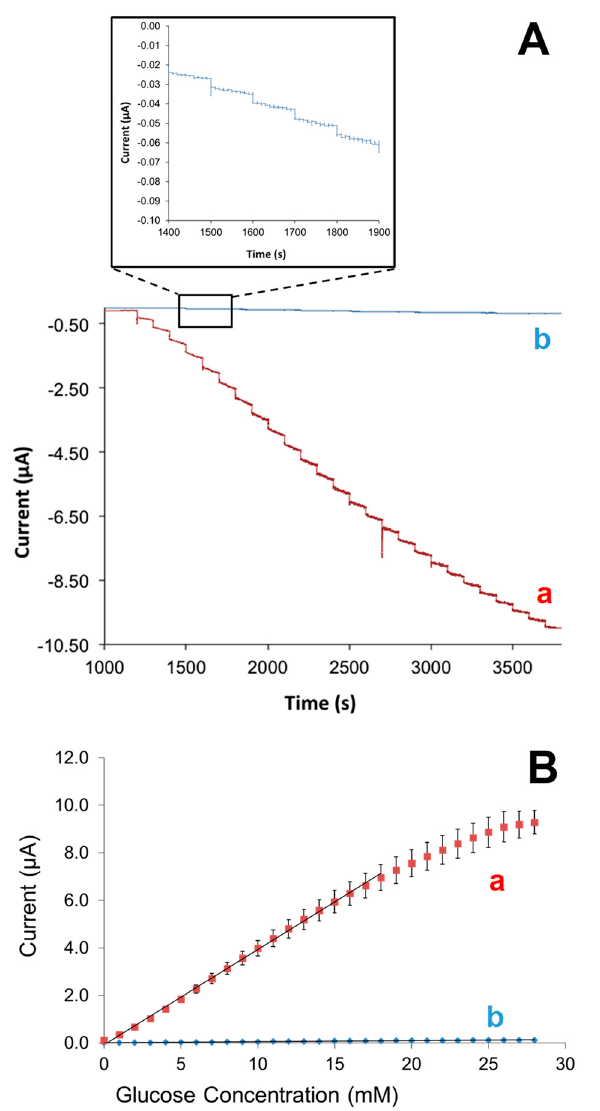
Figure 7. ( A ) Amperometric I-t curves and ( B ) corresponding calibration curves during successive 1 µM injections of glucose at a Pt-Ir wire electrode modified with GOx-doped OTMS xerogel, undoped OTMS xerogel, polyphenol, polyurethane layer (50% HPU, 50% TPU), and epoxy cap both ( a ) with and ( b ) without a Pt-black under-layer. Solution: 60.0 mM PBS, pH = 7.4, µ = 155 mM. Note: The error bars represent standard error (n ≥ 4).